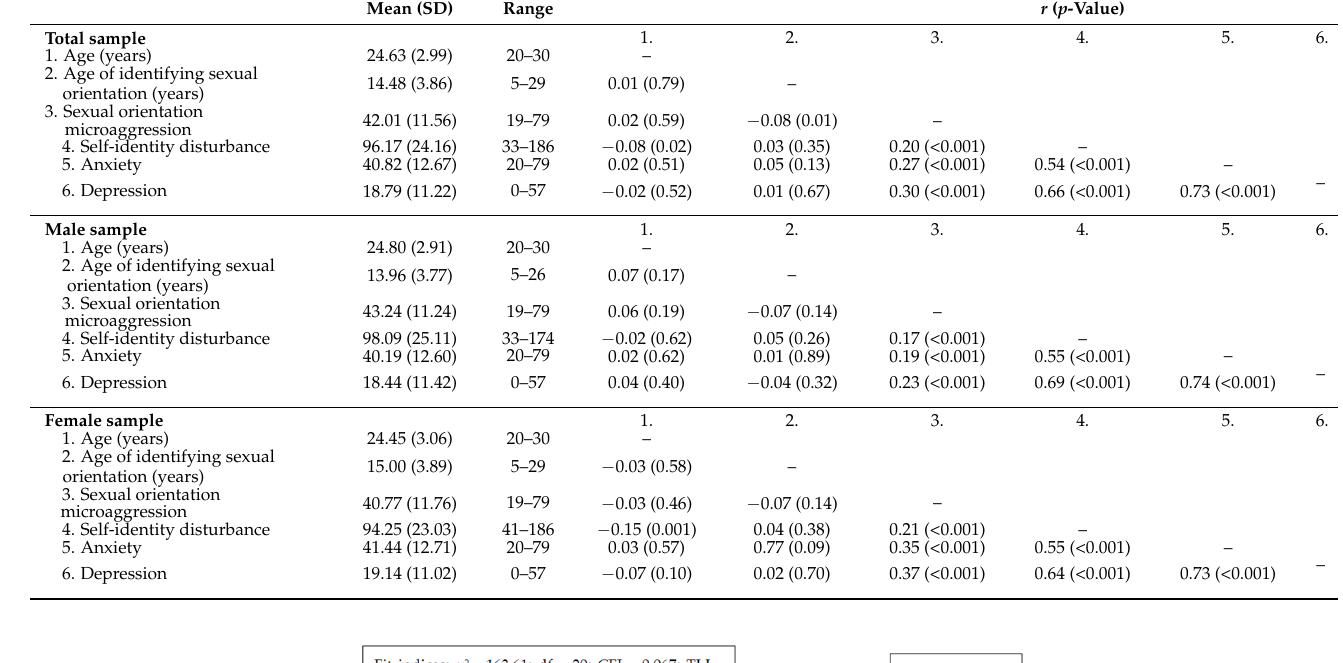
Table 2. Correlation matrix between studied variables.